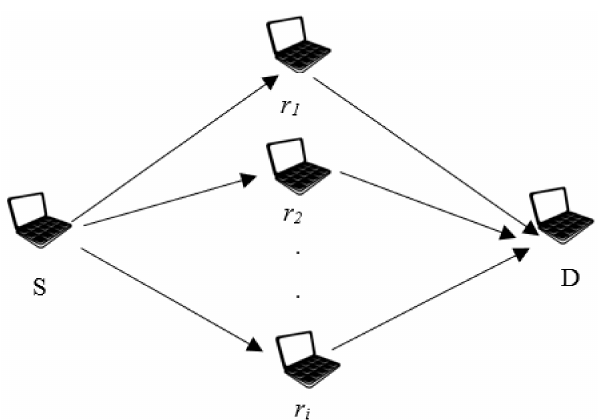
Figure 1. Example of cooperation with several relay nodes. S = source; D =